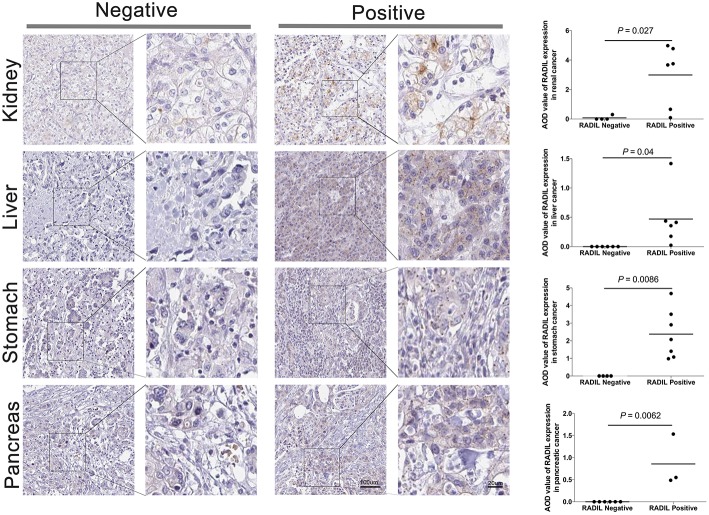
Validation of the prognosis of RADIL. Tumor tissues had higher rates to express RADIL in renal cancer (P = 0.027), liver cancer (P = 0.04) and stomach cancer (P = 0.0086) than that in the negative control groups. While in pancreatic cancer, tumor tissues had a lower RADIL expression (P = 0.0062).